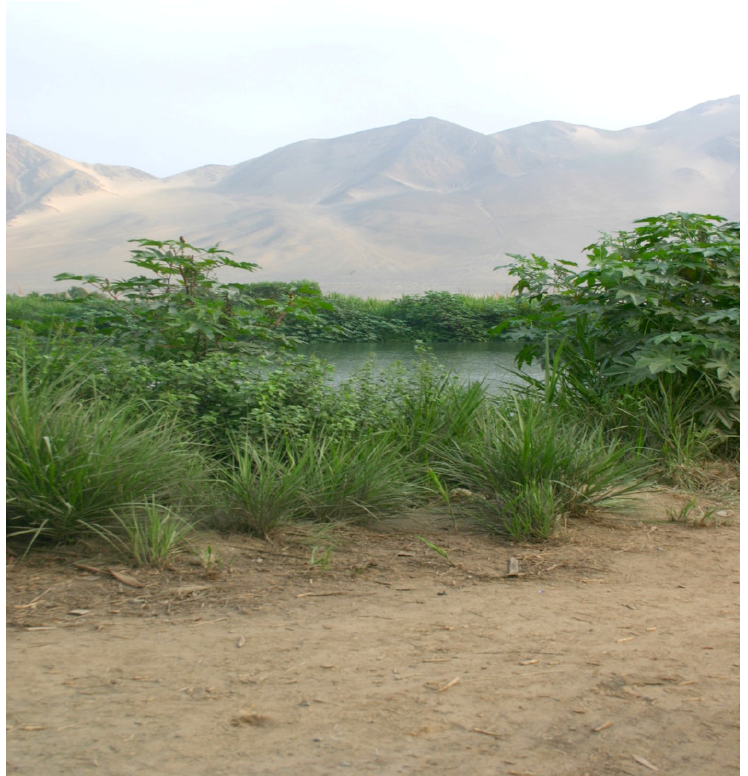
Figure 9. Typical interior Supe Valley pool derived from low-valley areas intersecting the high water table.